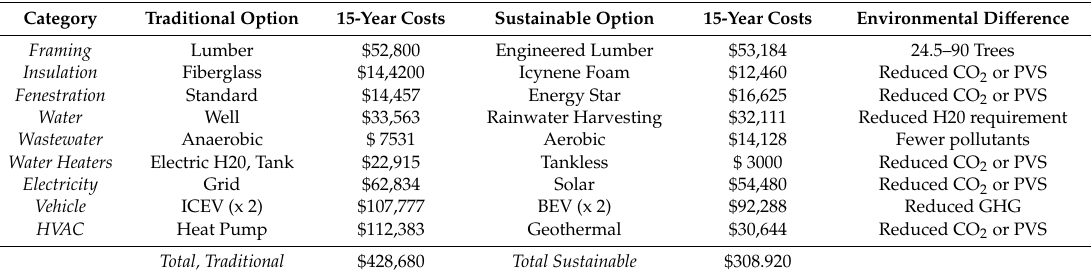
Table 1. Construction categories and components evaluated (inflation at 3% per